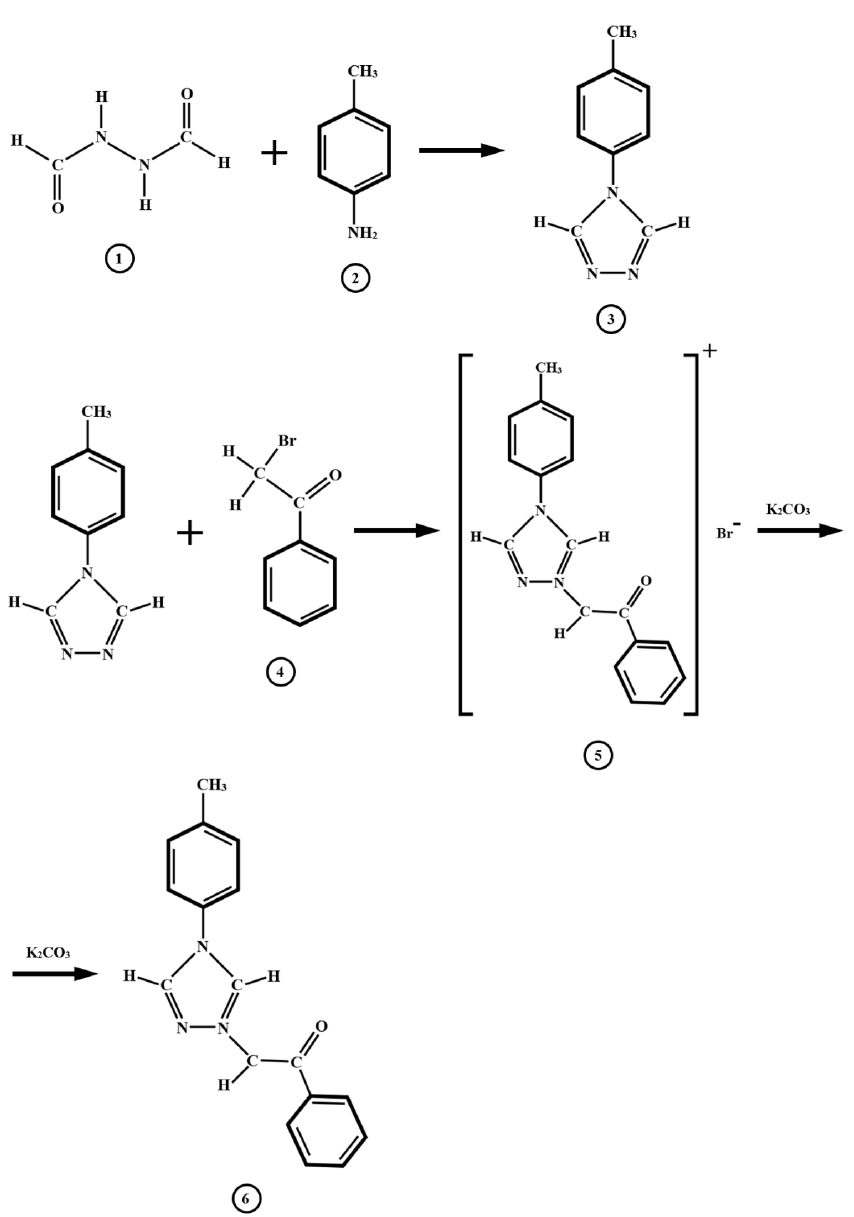
Figure 13. Schematic of the chemical reactions by which 4-tolyl-1,2,4-triazol-1-ium phenacylid (TTPY) was obtained ( 1 — 1,2-Diformylhydrazine, 2 — p -Toluidine, 3 — p -Tolyl-1,2,4-triazol-1-ium, 4 — 2-Bromoacetophenone, 5 — TTPY salt, and 6 — TTPY).